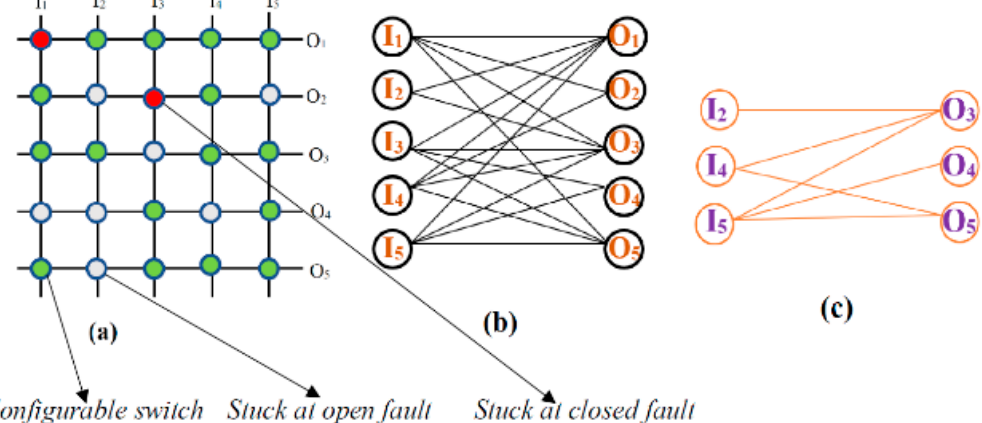
Figure 2. Representation of ( a ) a defective crossbar; ( b ) a bipartite graph representation of the crossbar by considering only the stuck at open fault; and ( c ) a bipartite graph representation of the crossbar by considering both stuck-at-open and -closed faults.